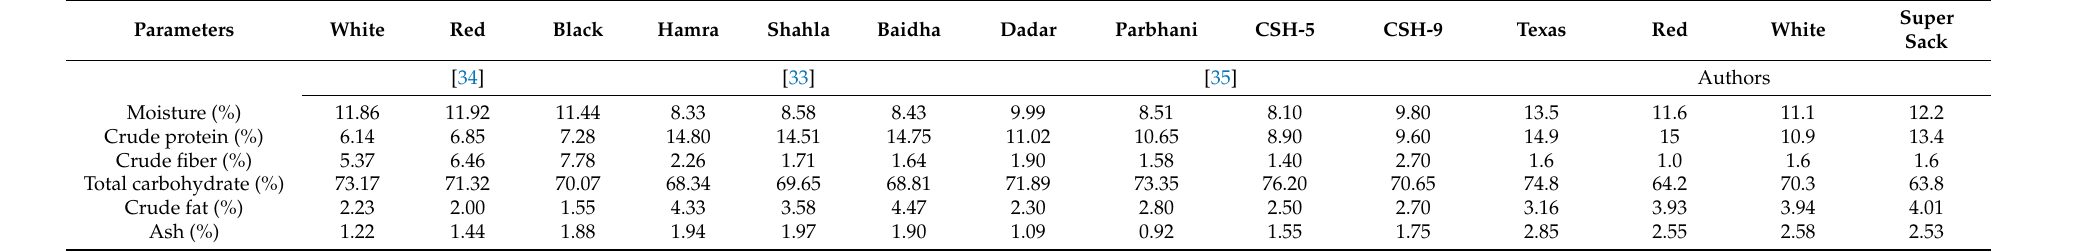
Table 4. Proximate composition of some sorghum